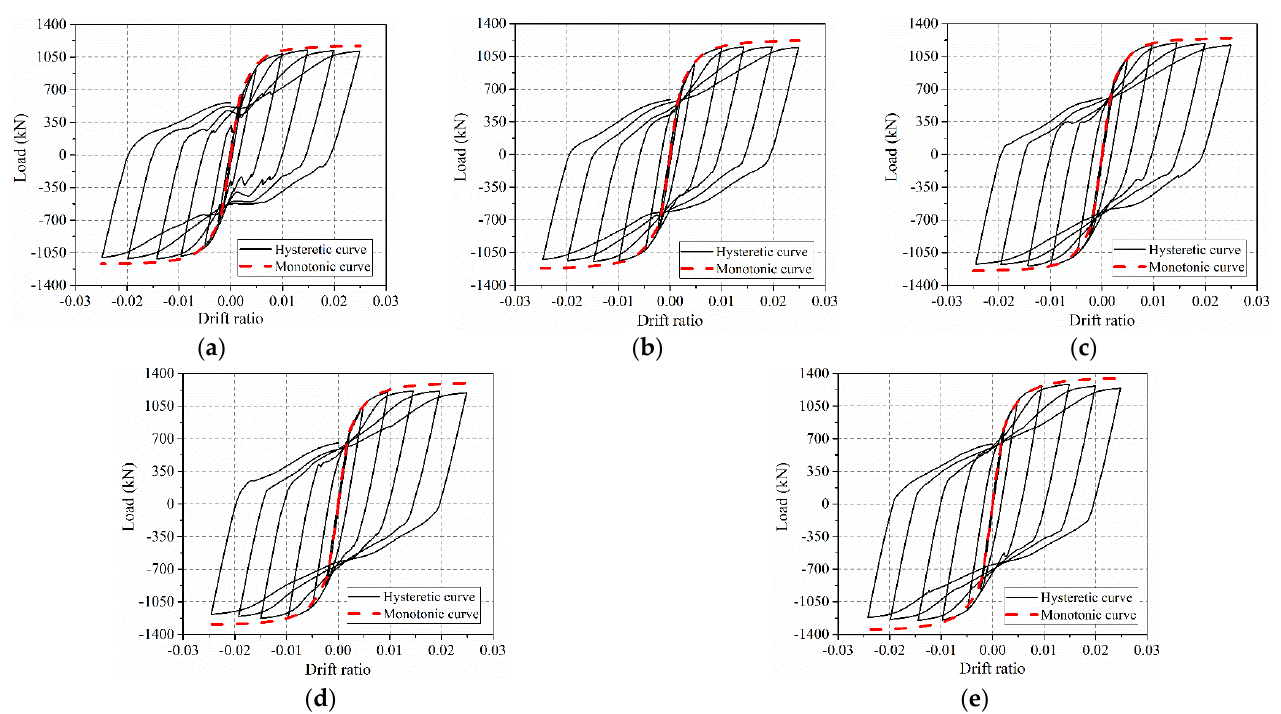
Figure 9. Hysteretic curves for SPSW1 − 3VHS with different η: ( a ) η = 10; ( b ) η = 30; ( c ) η = 60; ( d ) η =90; ( e ) η = 120.